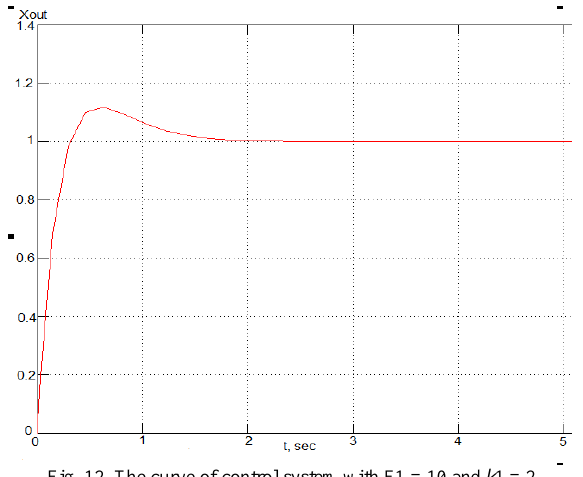
Fig.15. All output signals are equal to zero.